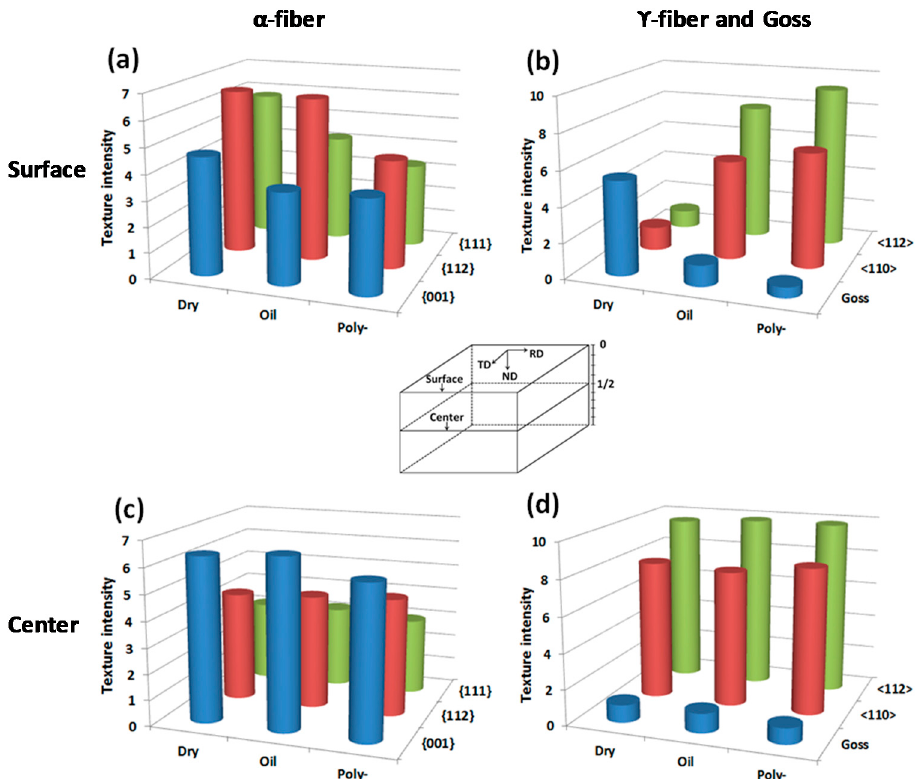
Figure 1. The influence of lubrication conditions on the surface and centreline textures of the ferrite rolled strip: ( a ) α -fiber and ( b ) γ -fiber and Goss texture of surface layer; ( c ) α -fiber and ( d ) γ -fiber and Goss texture of center layer under different lubrication conditions with rolling reduction of 40% at 700 °C.